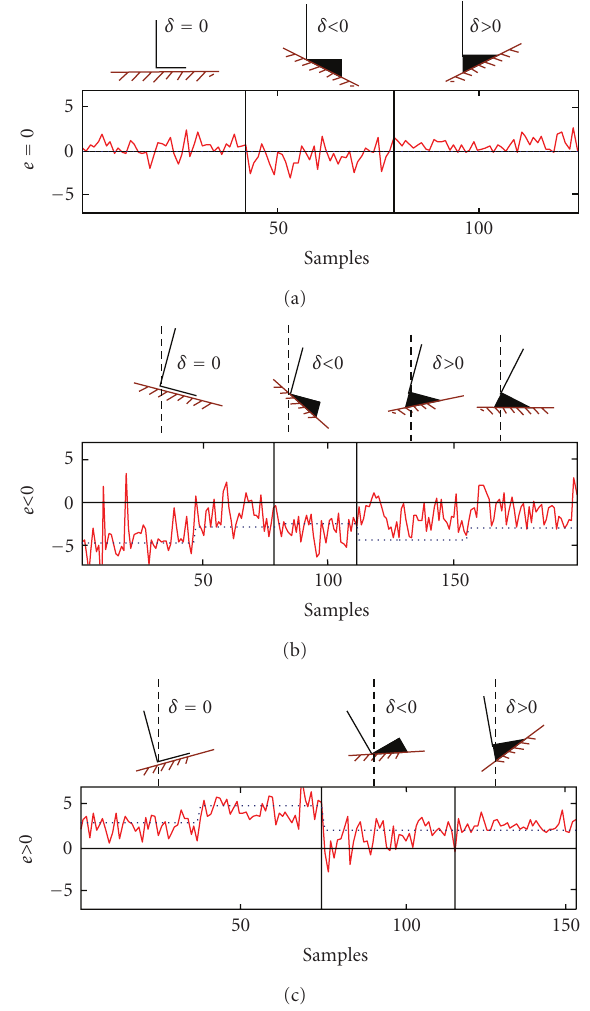
Figure 7: Control error of test subject B at di ff erent inclinations and control angles ( δ : keel angles), theoretical (dotted) calculated from (16) and estimated (solid) during fast walking using